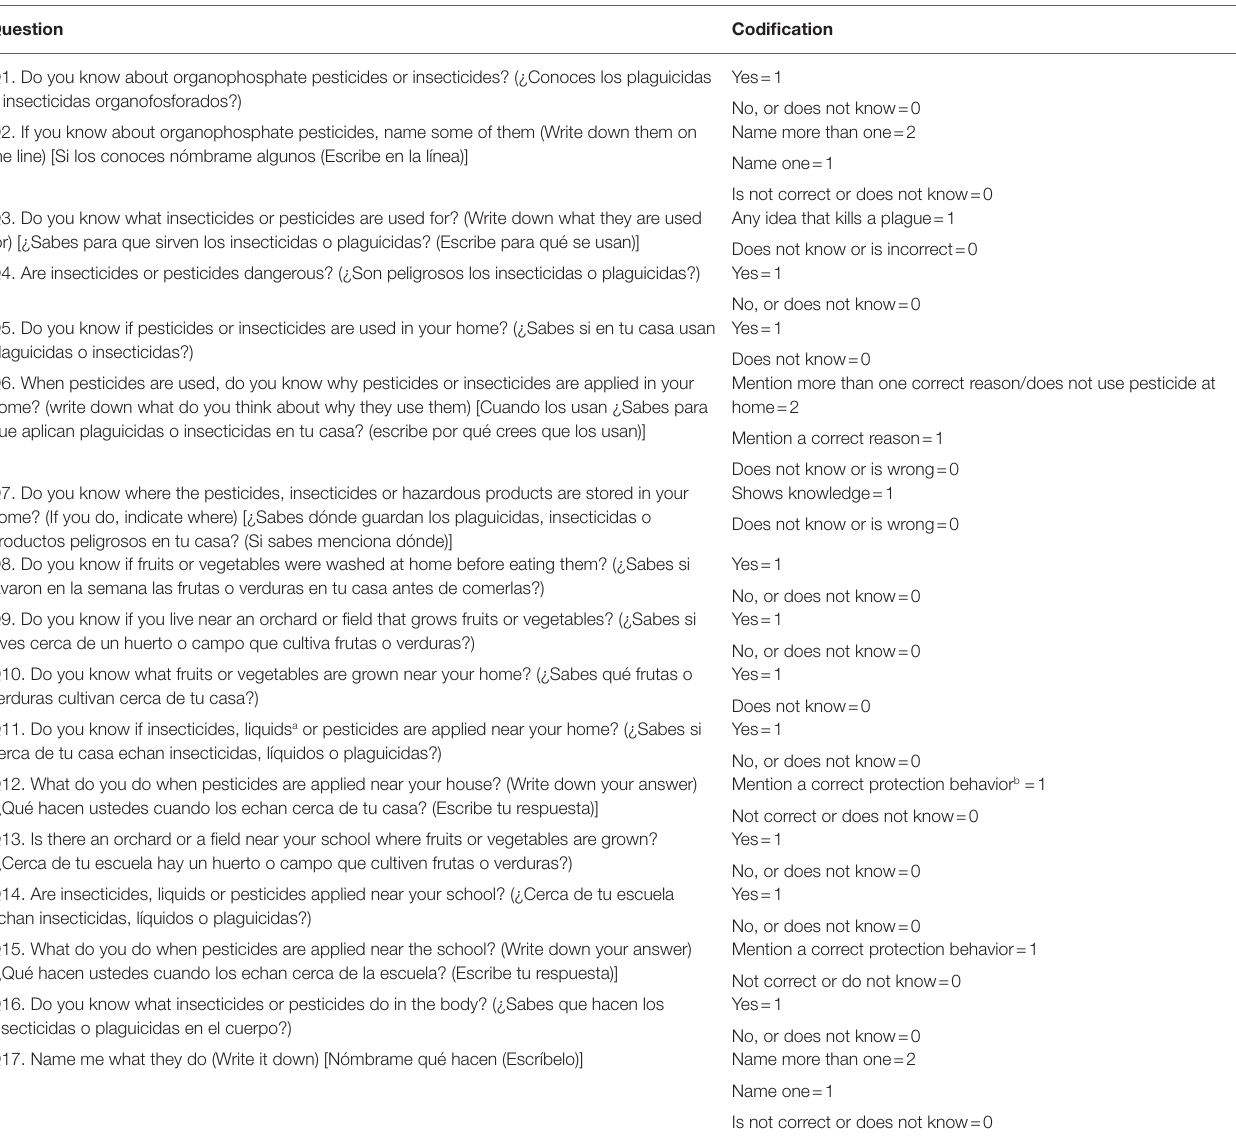
TABLE 1 | Questions and codification of the knowledge and perception questionnaire of pesticide exposure for schoolchildren. Question